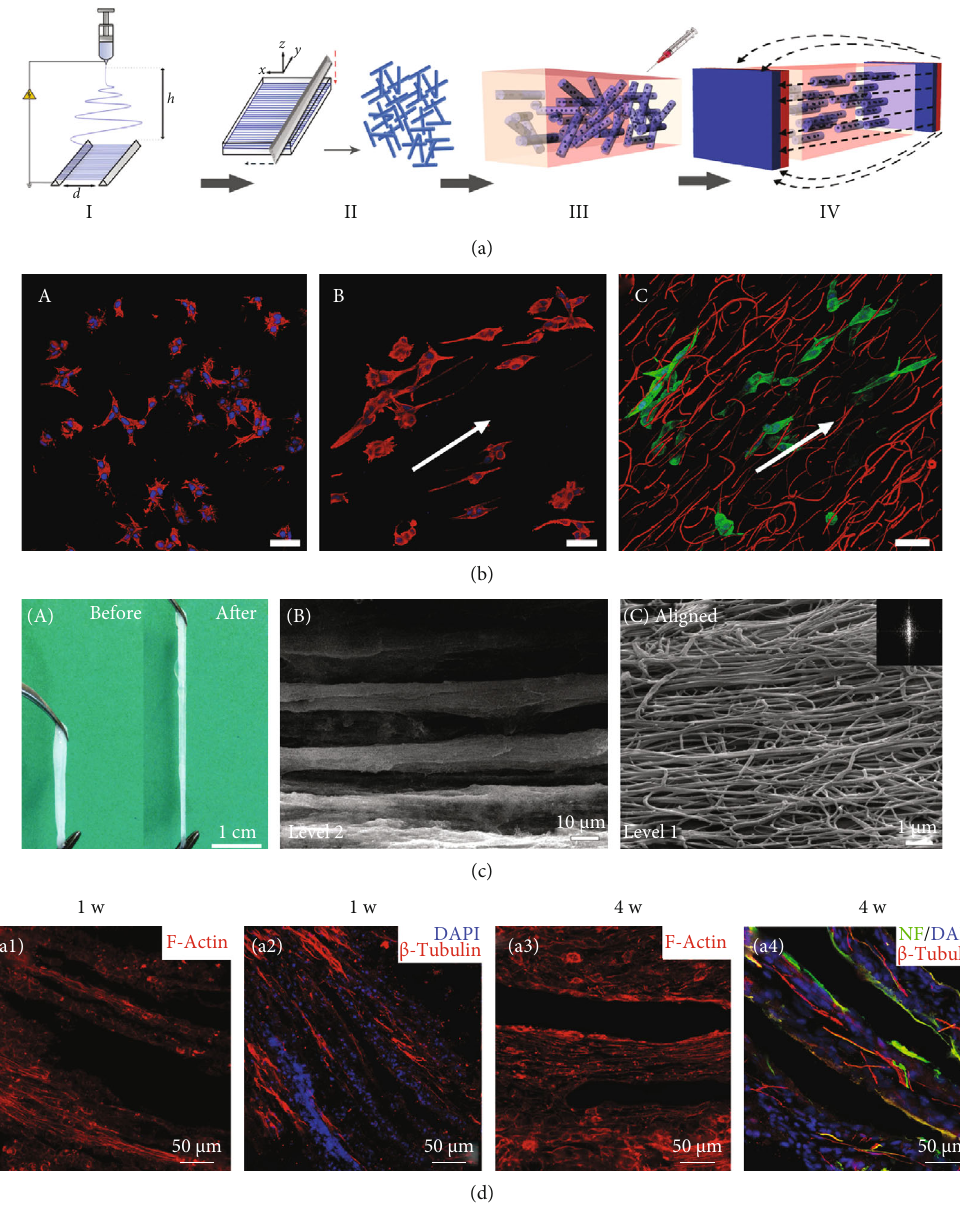
Figure 8: Electrospun nano fi bers in 3D sca ff olds and their e ff ects on cell alignment and neural di ff erentiation. (a) A schematic illustration of the fabrication process of Anisogel. Electrospinning of aligned fi bers (step I). Short fi bers forming by cryosectioning (step II). Randomly oriented short fi bers mixed within the hydrogel precursor solution before gelation and applying the magnetic fi eld (step III). Fiber orientation under low magnetic fi eld and hydrogel crosslinking result in the Anisogel (step IV). (b) The ability of the Anisogel to direct cell growth. (A) Fibroblasts mixed within a fi brin gel without fi bers, (B) fi broblasts mixed within a fi brin gel with short oriented fi bers, and (C) fi broblasts elongate in the direction of the oriented fi bers. Scale bars 50 μ m. Reproduced with permission from [80], Copyright © 2017, WILEY-VCH Verlag GmbH & Co. KGaA, Weinheim. (c, A) Electrospun-aligned fi brillar fi brin hydrogel with good fl exibility. (B, C) Hierarchically aligned microstructure at di ff erent magni fi cations. (d) Immuno fl uorescence staining images of the longitudinal tissue section from the T8 – T10 spinal cord segment at 1 and 4 weeks after sca ff old implantation. Reused with permission from [149]. Copyright © 2016, Royal Society of